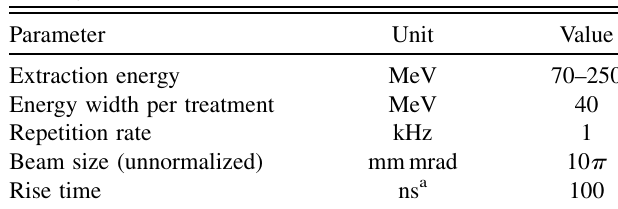
TABLE XVI. Requirements of beam extraction system of pro- ton ring.